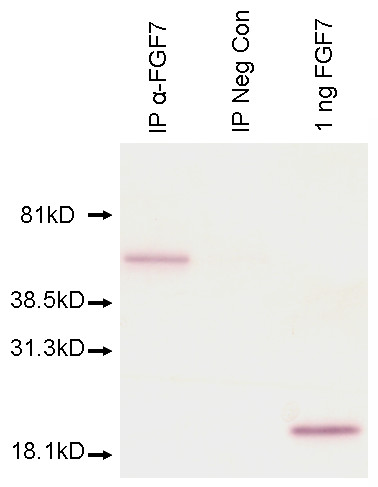
Western blot of FGF-7 in immunoprecipitate of fibroblasts. The polyclonal antibody recognized the positive control (approximately 22 kD; human FGF-7, lane 3) and did not bind to an immunoprecipitate of an irrelevant cell line (IP negative control, lane 2). The immunoprecipitate of the fibroblasts in lane 1 yielded a band at approximately 66 kD, which we attributed possibly to binding of FGF-7 to a heparan sulfate proteoglycan in the cell membrane.